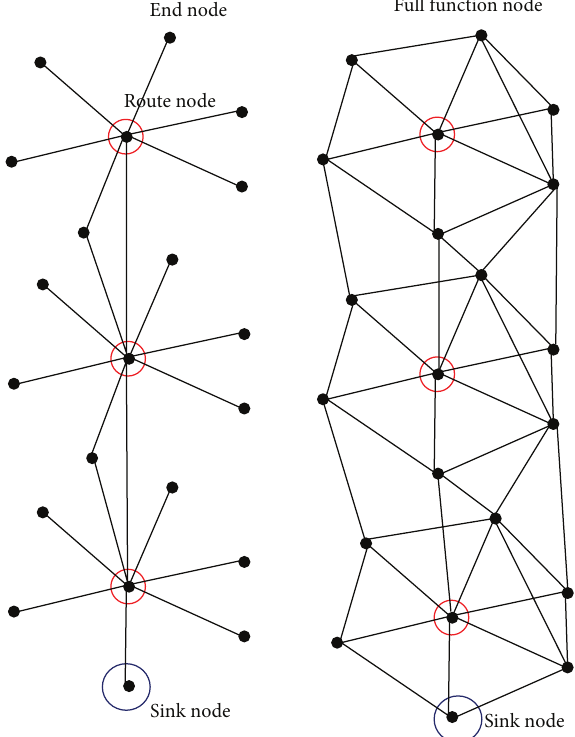
Figure 3: Modern complexity topology of normal condition moni- toring